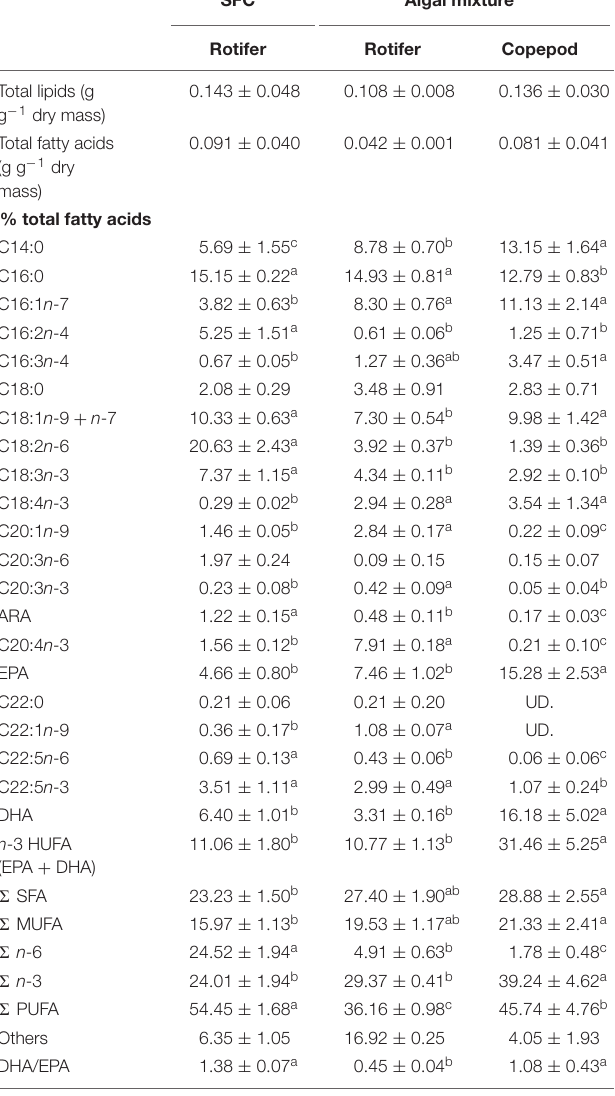
TABLE 3 | Fatty acid proportions in non-polar lipids of preys enriched with docosahexaenoic acid-supplemented Super Fresh Chlorella (SFC), or algal